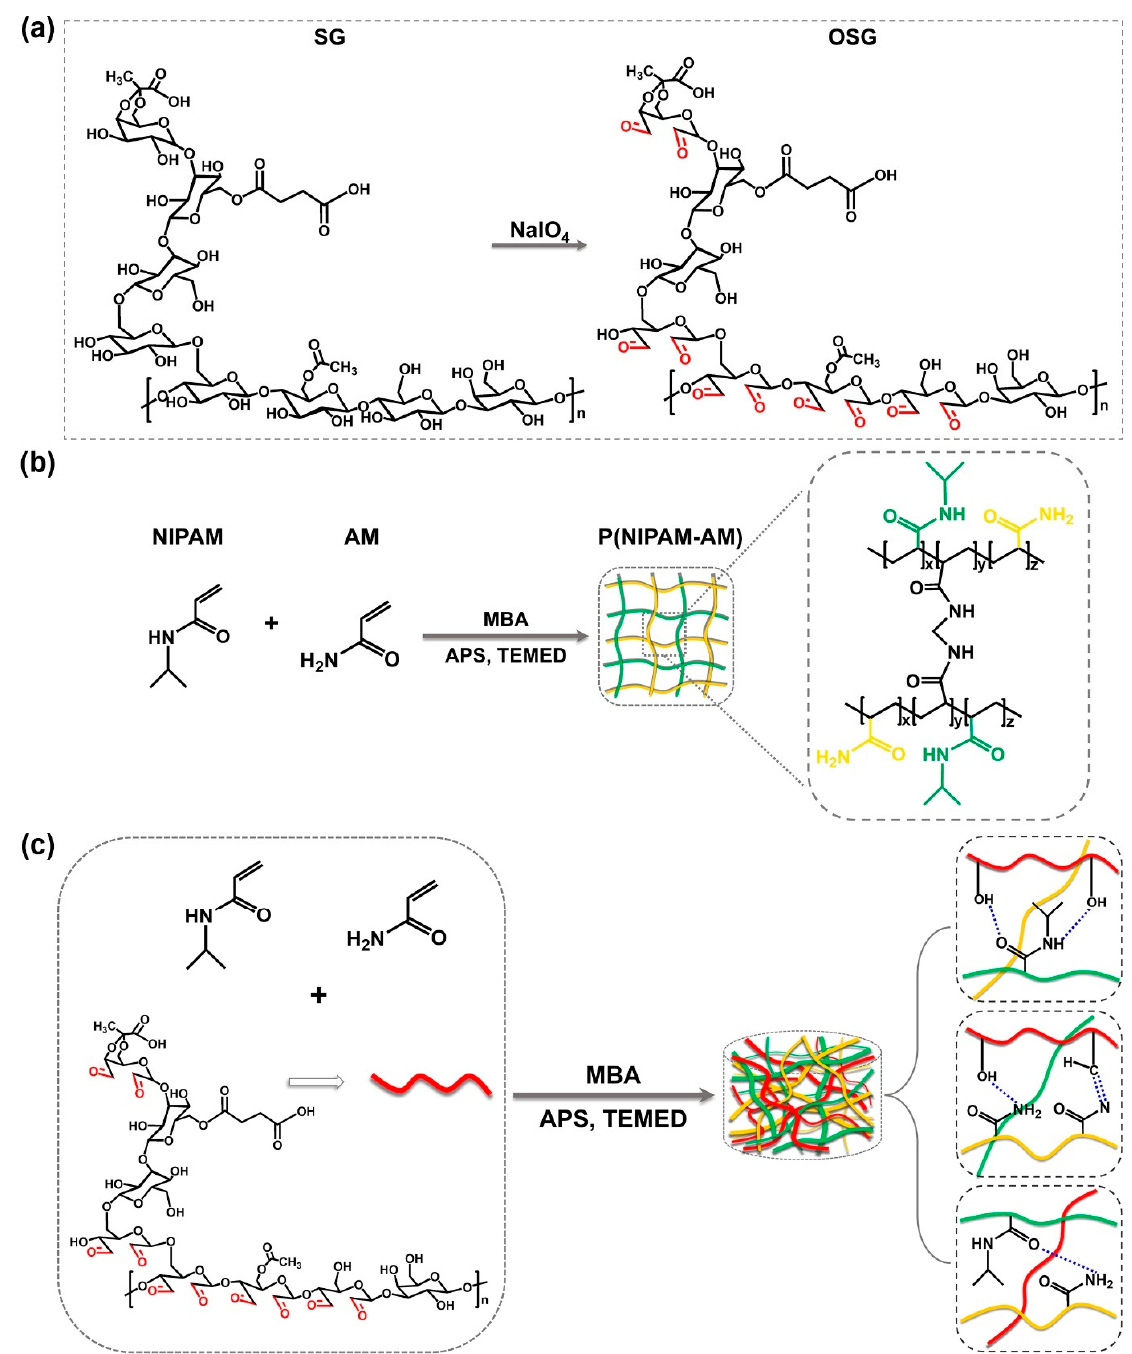
Scheme 1. Illustration of the proposed microstructure and fabrication mechanism of OSG/P(NIPAM-AM)